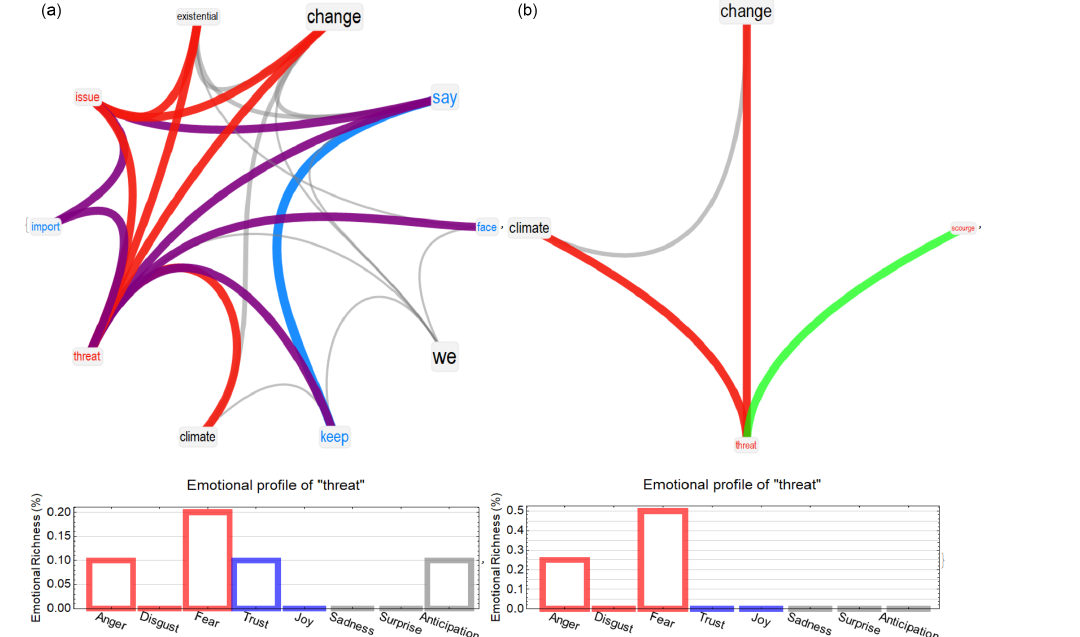
Figure A3. Speakers’ mindset reconstruction around “threat” in the speeches of Greta Thunberg (a) and Christopher Monckton (b) . We refer the reader to Fig. 1 for a detailed explanation of the colour code and to Lexicon 1 for an interpretation of the figure.